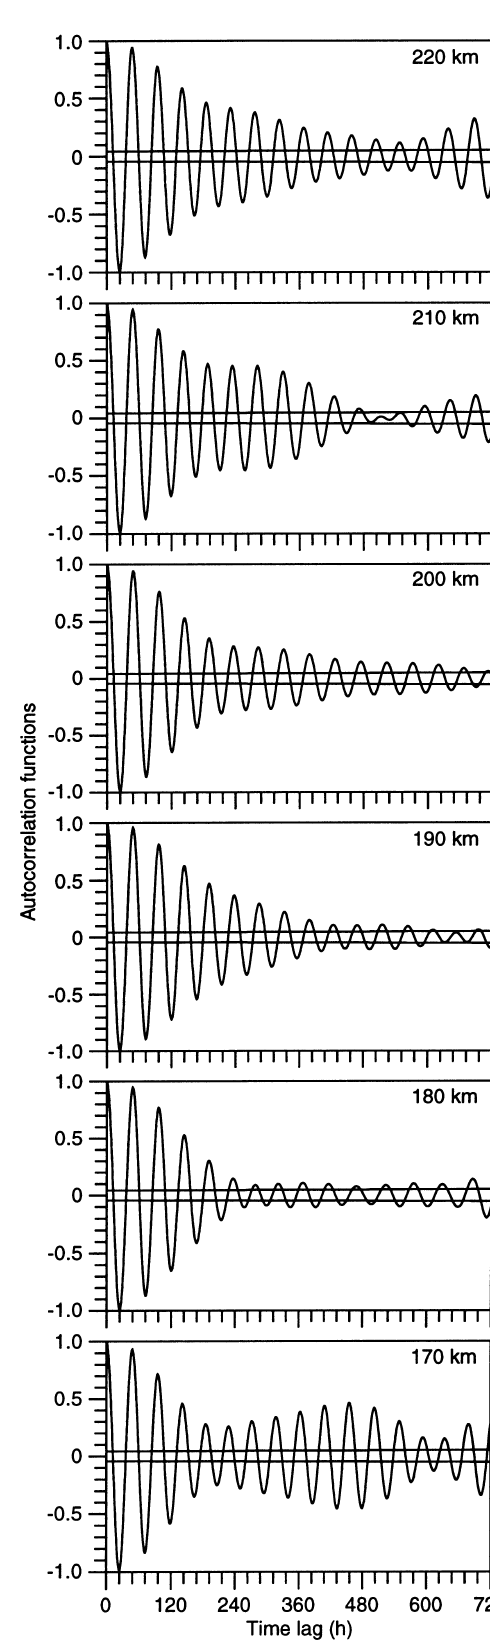
Fig. 4. The left panel shows the filtered data of the plasma frequency at fixed heights corresponding to the quasi-2-day oscillation obtained from May 24 to August 22 of 1995. The right panel displays the auto-